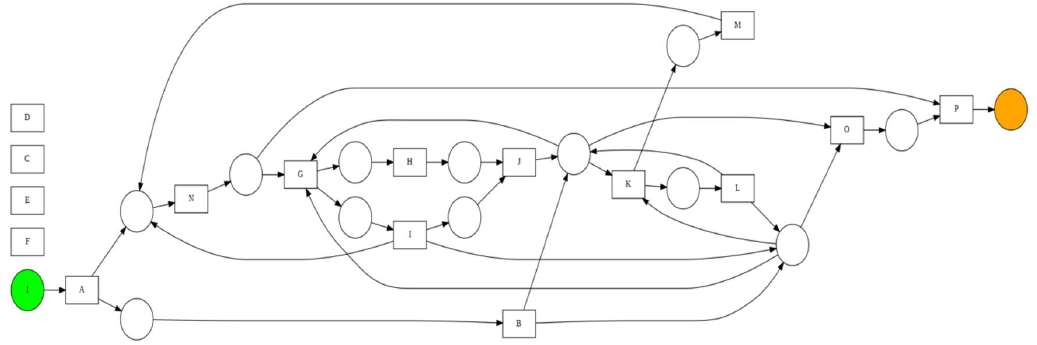
Fig. 6 Alpha Miner process model results Fig. 6. The process model generated, activities C, D, E, F are not included in the process model structure. This happens because the existing event log data has short loops activity, including trace 33 (A, B, C, C, D, D, E, E, F, F, N, O, P).